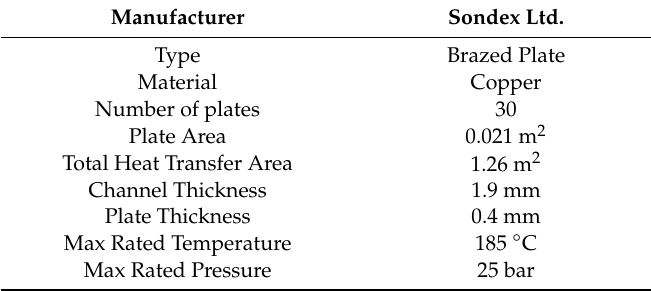
Table 3. Details of the heat